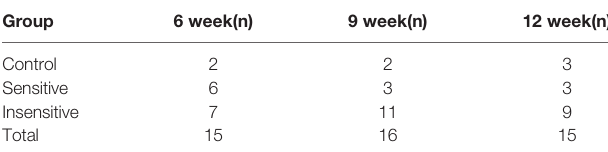
TABLE 2 | Statistical table of mouse